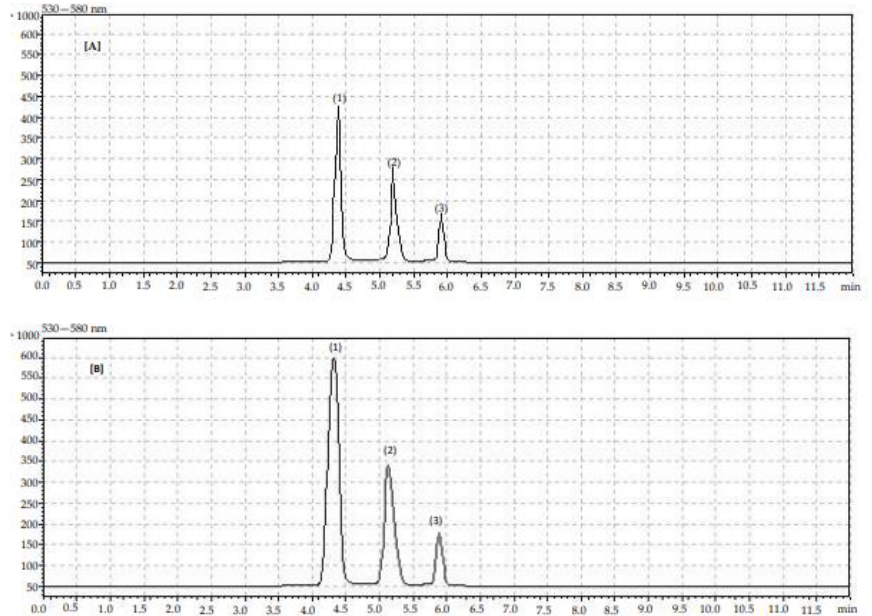
Figure 2. Chromatogram showing retention times for identified anthocyanin compounds in organic ( A ) and conventional ( B ) blue honeysuckle fruits: (1) cyanidin-3- O -glucoside, (2) cyanidin-3- O -rutinoside, (3) peonidin-3- O -glucoside.